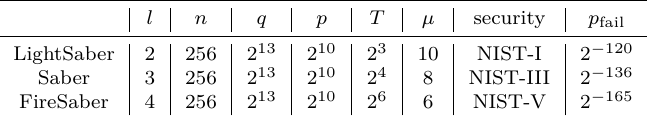
Table 1: Proposed parameters of round-3 Saber